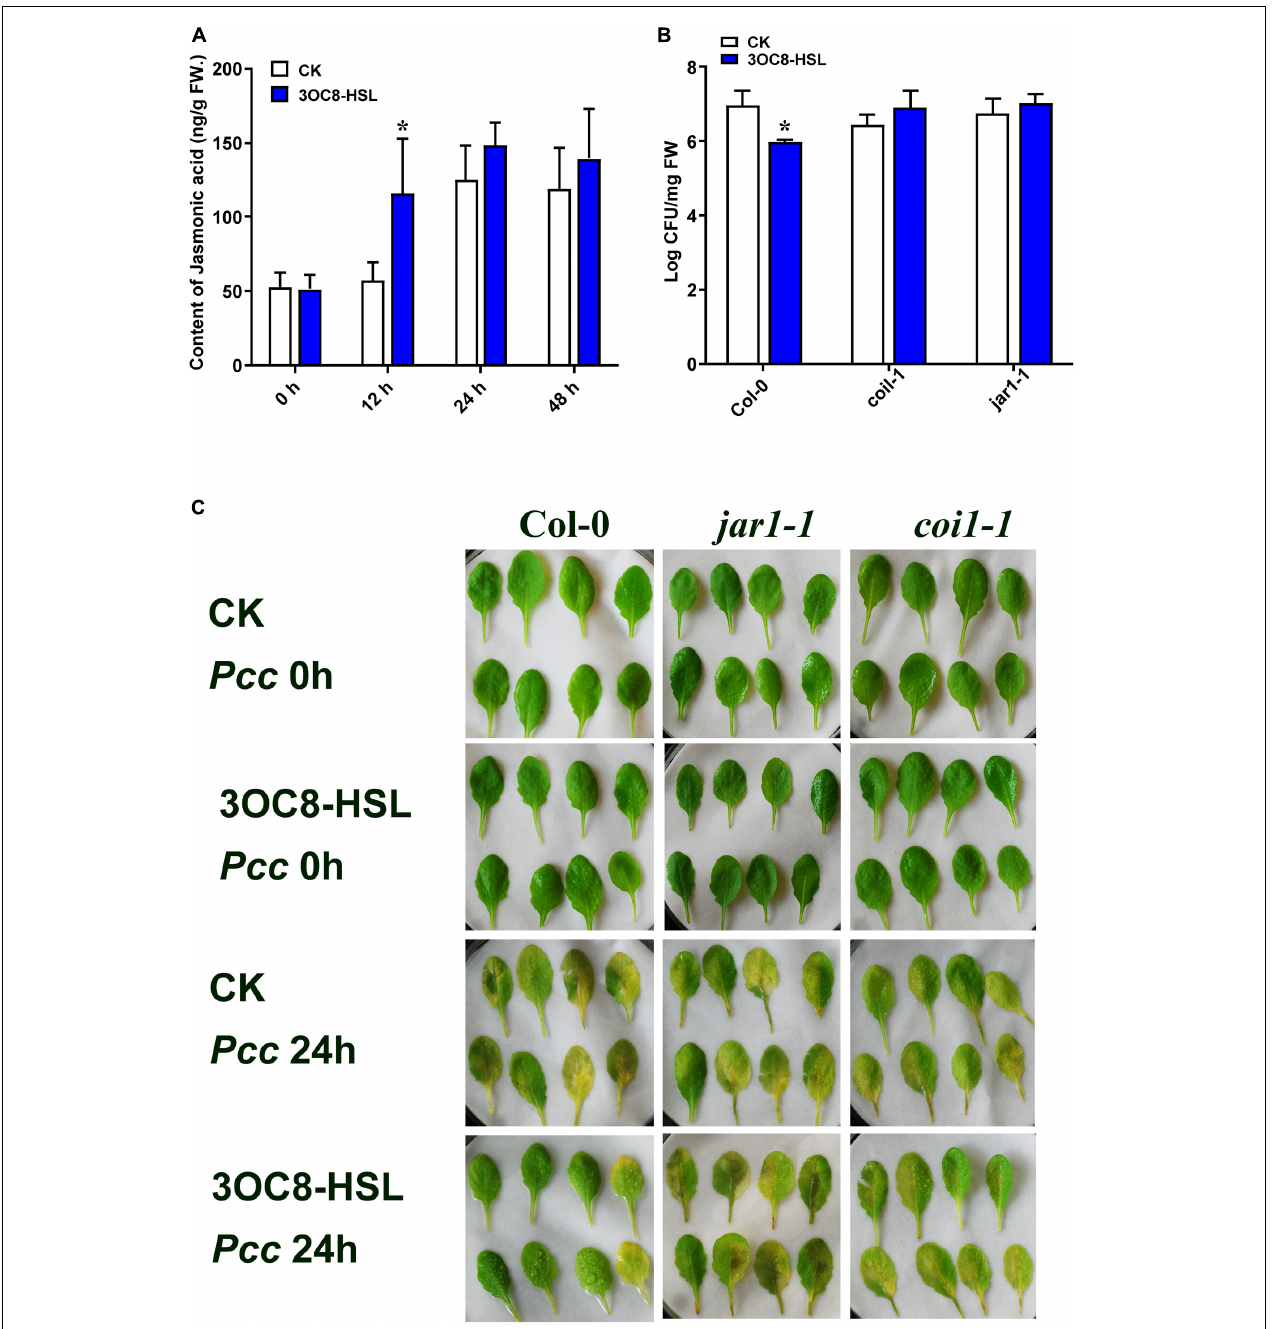
FIGURE 3 | Effects of 3OC8-HSL application on the accumulation of JA and effects of 3OC8-HSL on Pcc growth in wild-type Arabidopsis Col-0 , coi1-1, and jar1-1 . (A) Accumulation of free JA measured by HPLC in Arabidopsis plants in which the roots were pretreated with 10 µ M 3OC8-HSL for 48 h and the leaves were subsequently spray-inoculated with 10 7 CFU/mL Pcc . (B) Proliferation of Pcc in the leaves of Col-0 , coi1-1, and jar1-1 . (C) Symptoms of Pcc infection Col-0 , coi1-1, and jar1-1 . At least five independent experiments were performed, each of which with three technical repeats. Asterisks indicate a statistically significant difference between the AHL-pretreated and the water-treated plants (ANOVA test, * P < 0.05). Values are means ± SD of six independent experiments.